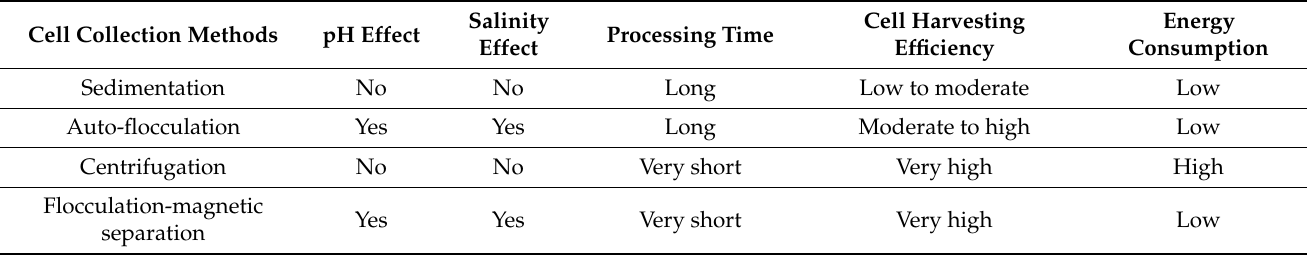
Table 5. Comparison of different microalgal cell harvesting